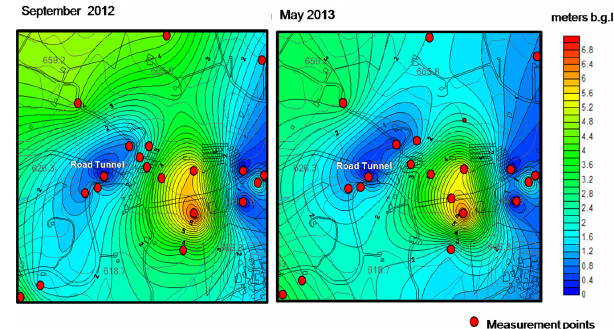
Figure 12. Isopiezometric maps. Groundwater is consistently close to ground level, and little fluctuations were identifed between the periods of maximum and minimum acquifer